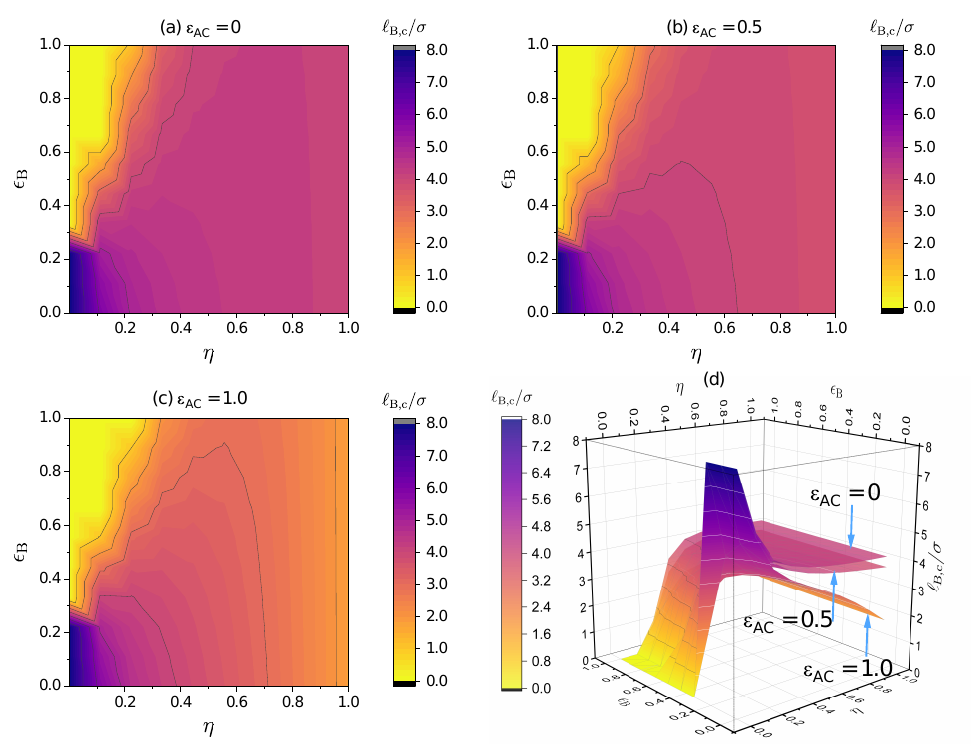
Figure 14. Critical Bjerrum length ( (cid:96) B,c / σ ) for the critical points in the binodal curves. The values for the following parameters were fixed: (cid:101) A = 0, N T = 100, Z C = + 1 and Z A = − 1 and ( a ) (cid:101) AC = 0, ( b ) (cid:101) AC = 0.5 and ( c ) (cid:101) AC = 1.0. Values for η and (cid:101) B were varied, therefore, N 1 = N T η − 1 N 1 was varied as well. ( d ) The 3D surfaces for ( a – c ). Notice that the maximum of (cid:96) B / σ shown here is (cid:96) = B / σ